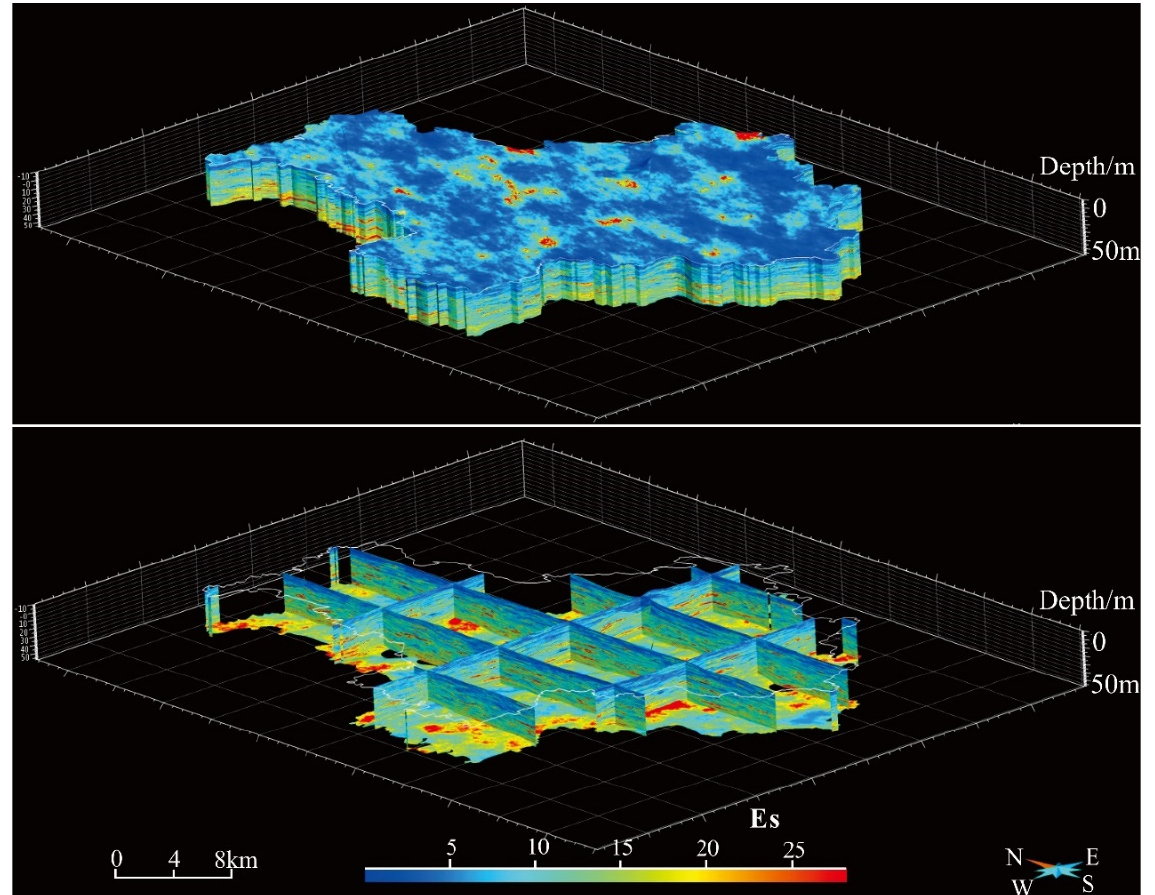
Figure 15. Three-dimensional geological model of shallow superficial deposits in Tongzhou District. Upper: E s -attributed 3D geological model; below: fence diagrams of the model.